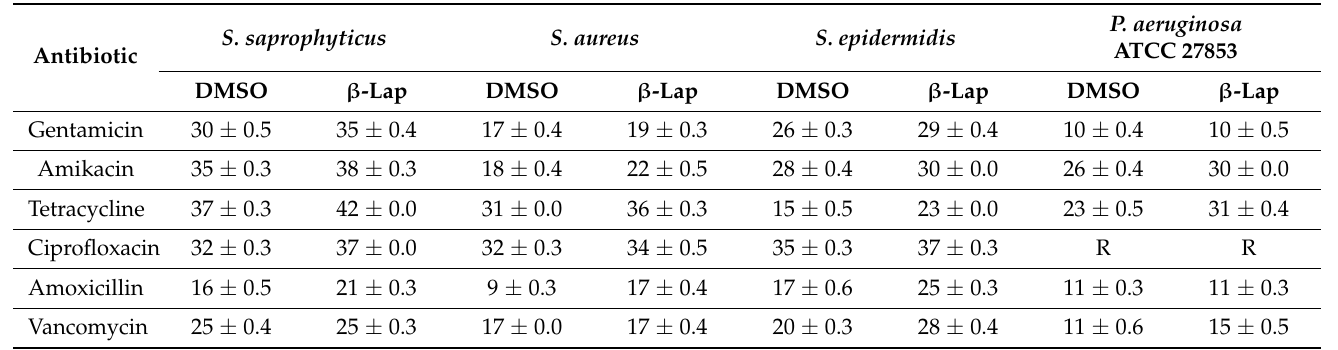
Table 2. Zone of inhibition (mm ± SD) of antibiotics and of their combination with commercial